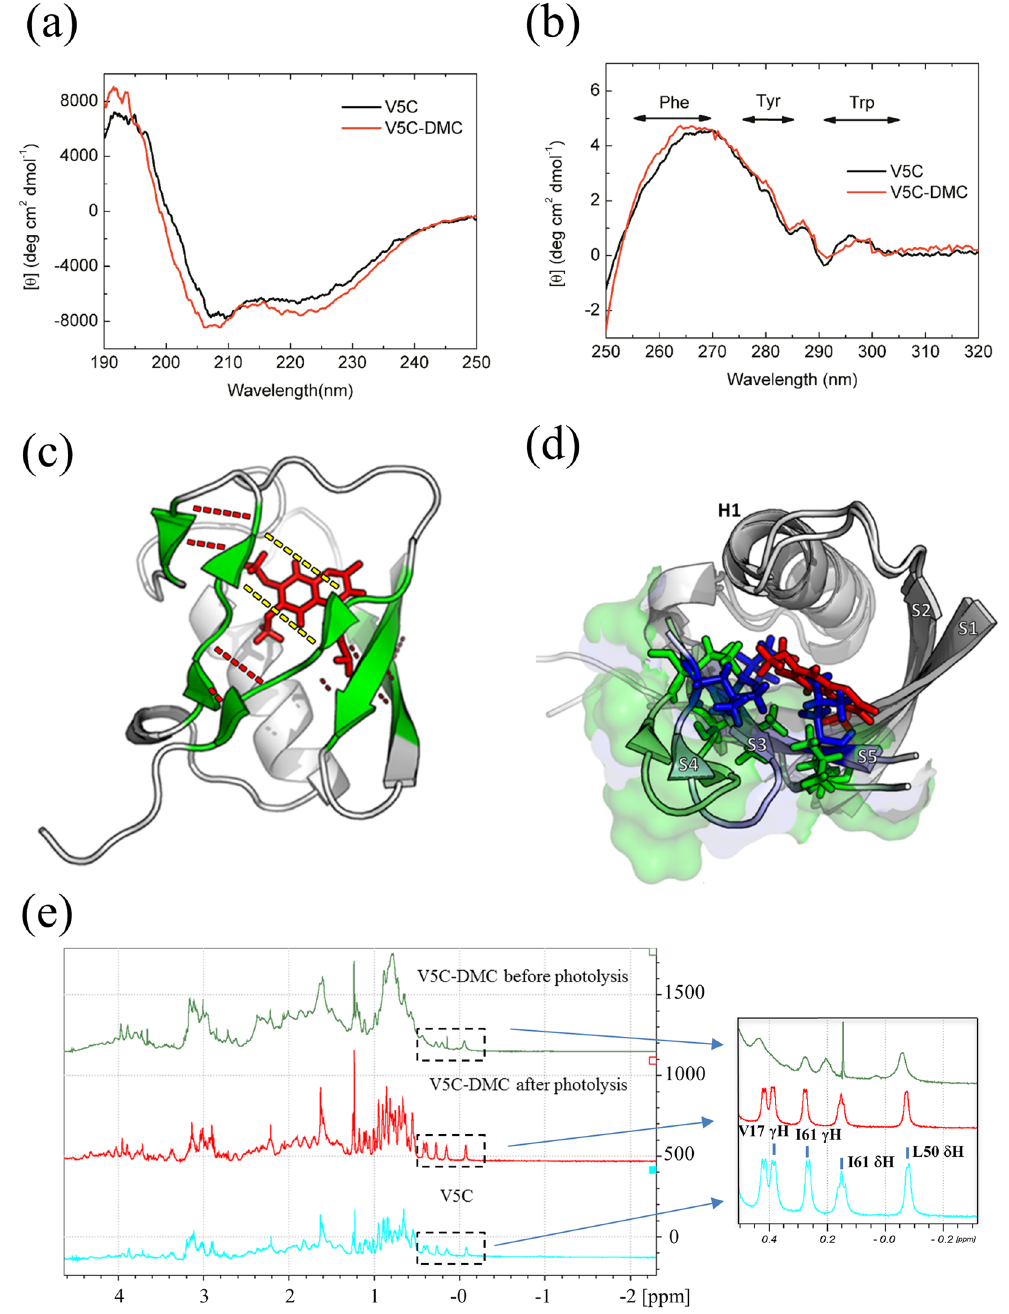
Figure 3. Structural comparison between V5C and V5C-DMC using CD, NMR and MD simulation. ( a ) Far-UV CD spectra of V5C and V5C-DMC. ( b ) Near-UV CD spectra of V5C and V5C-DMC. V5C and V5C- DMC were dissolved in DI (pH 5.7) to a final concentration of 4.76 and 6.59 μ M for ( a ) and 40.9 and 44.2 μ M for ( b ), respectively. ( c ) Hydrogen bonding networks in β -sheet of the simulated V5C-DMC structure. Red sticks: DMC. Green ribbons: β -strands. Red dotted lines: hydrogen bonds. Yellow dotted lines: hydrogen bonds lost in V5C-DMC but present in V5C. ( d ) Rearrangement of residues in the hydrophobic core of V5C-DMC. Green sticks: rearranged residues 43, 50 and 67 after simulation. Red sticks: DMC-conjugated Cys5 in the simulated V5C-DMC structure. Blue sticks: original positions of residues 43, 50 and 67 in V5C. If DMC was directly conjugated onto Cys5 without relaxing the structure, there is steric hindrance in residues 43, 50 and 67. The local protein surface was shown in light blue for V5C and light green for V5C-DMC. β -Strands are labeled as S1 - S5; helix 1 is labeled as H1. ( e ) Comparison of the 1D-NMR spectra of V5C (light blue), V5C-DMC before photolysis (green), and V5C-DMC after photolysis (red). The concentration of V5C and V5C-DMC is 175 and 20 μ M, respectively. The concentration of photolytic product of V5C-DMC, i.e. refolded V5C, is 60 μ